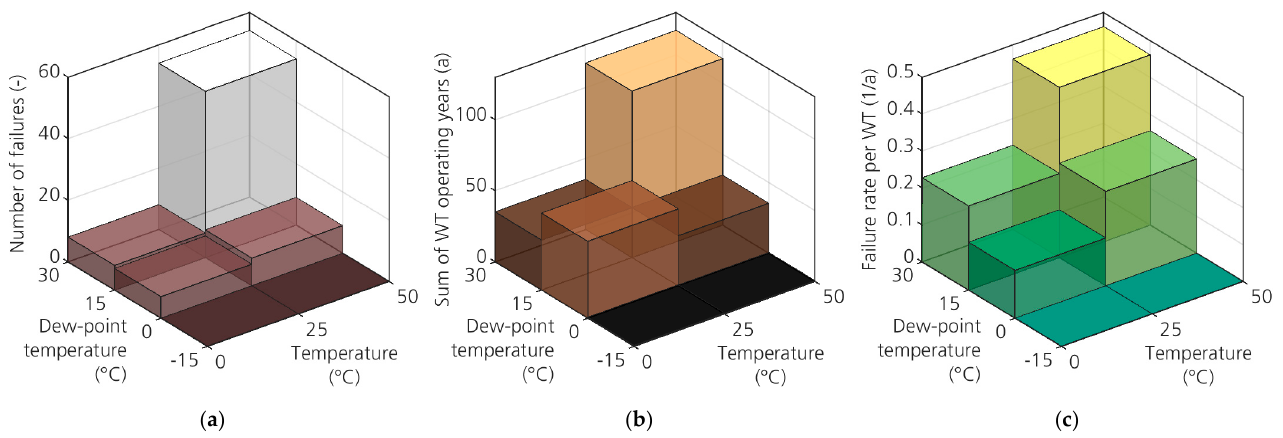
Figure 4. Analysis of the ambient climatic conditions at the time of failure (based on a field data subset from 243 WT operating years in India); absolute number of phase-module failures per bin of temperature and dew-point temperature ( a ), overall WT operating time at the respective ambient conditions ( b ) and resulting average phase-module failure rates ( c ).